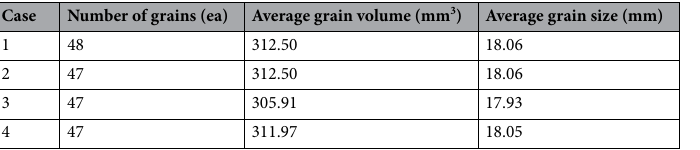
Table 1. Number of grains, average grain volume and size of Voronoi cells from individual samplings.